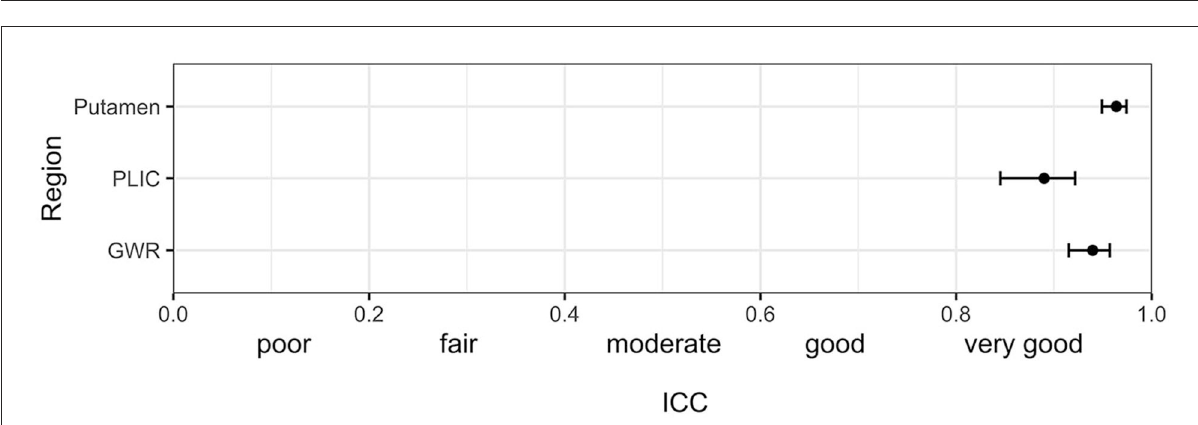
FIGURE3 Intraclass correlation (ICC) (95%-CI) for the combined agreement of three human raters (mean of student, neurologist and neuroradiologist) with the computer algorithm in GWR and ROI assessment (Putamen and PLIC) in Hounsfield Units (HU) in CTs after cardiac arrest.